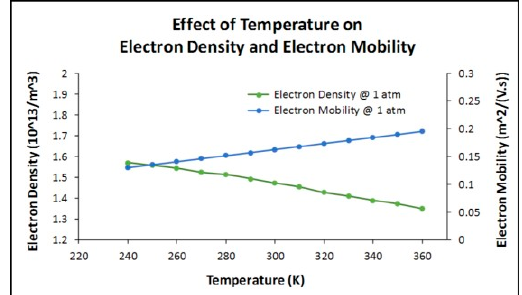
Figure 5. The effect of temperature on electron density and electron mobility at constant pressure of 1 atm.